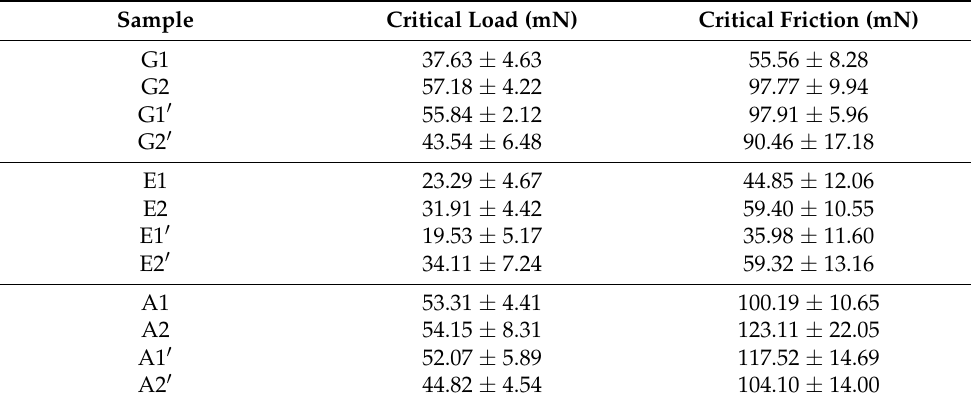
Table 4. The critical load and critical friction values determined from the scratch test of chit/EE100 coatings deposited on substrates prepared